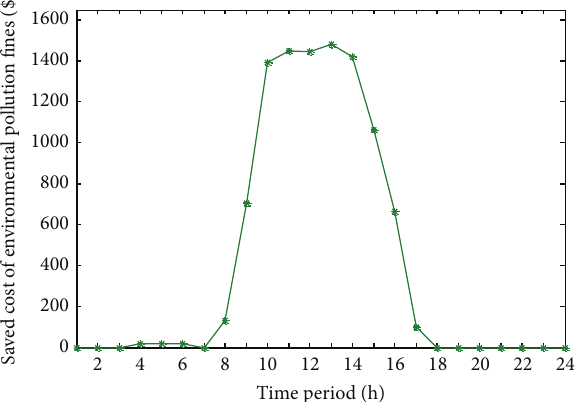
Figure 9: Hourly penalty reduction for pollutant